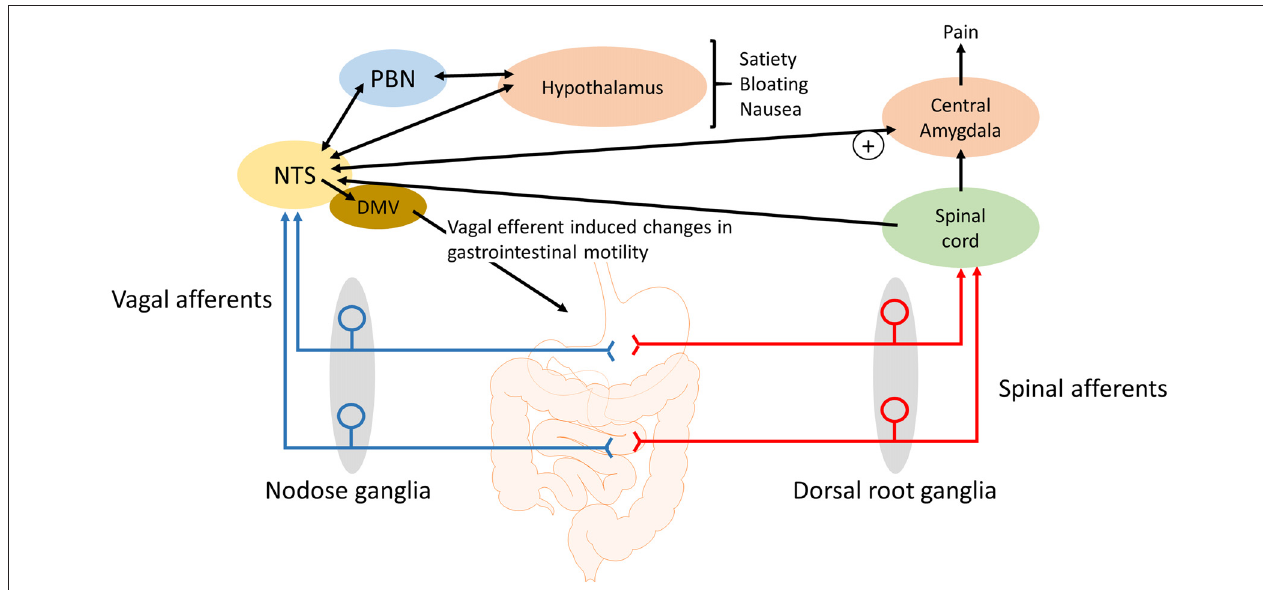
FIGURE 1 | Schematic of how gastrointestinal vagal afferents can be involved in the symptoms associated with functional dyspepsia. For simplicity not all neural pathways and regions are illustrated. The NTS receives input from vagal afferents innervating the gastrointestinal tract. Distinct neural outputs from the NTS coordinate sensations such as satiety, bloating and nausea. Further, neural output from the NTS to the central amygdala can modulate the processing of nociceptive information, from the spinal cord and brainstem, within the central amygdala. NTS, nucleus tractus solitarius; DMV, dorsal motor nucleus of the vagus; PBN, Parabrachial